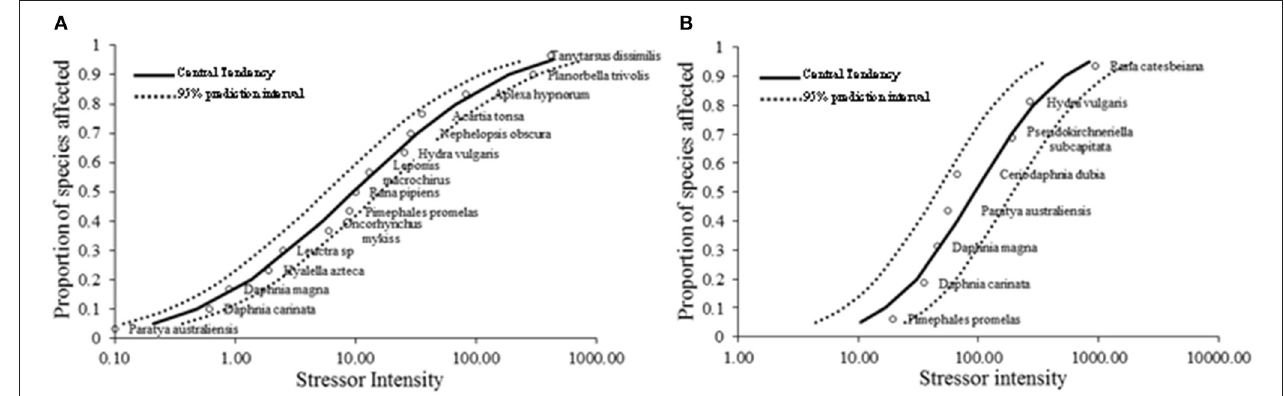
FIGURE 3 | Species sensitivity distribution (SSD) derived by the CADDIS SSD generator and SSD toolbox. (A) SSD of AgNO 3 acute toxicity, produced using fifteen species ( P. australiensis , D. carinata , D. magna , H. Azteca , Leuctra sp. , O. mykiss , P. promelas , R. pipiens , L. macrochirus , H. vulgaris , N. obscura , A. tonsa , A. hypnorum , P. trivolis, and T. dissimilis ). (B) SSD of AgNP acute toxicity, produced using eight species ( P. promelas , D. carinata , D. magna , P. australiensis , C. dubia , R. subcapitata , H. vulgaris, and R. catesbeiana